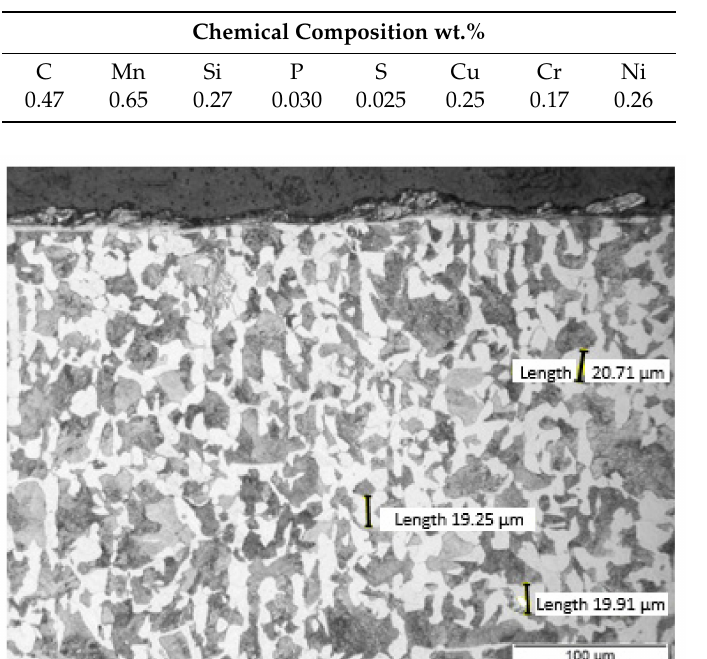
Table 1. Chemical composition of tested steel.